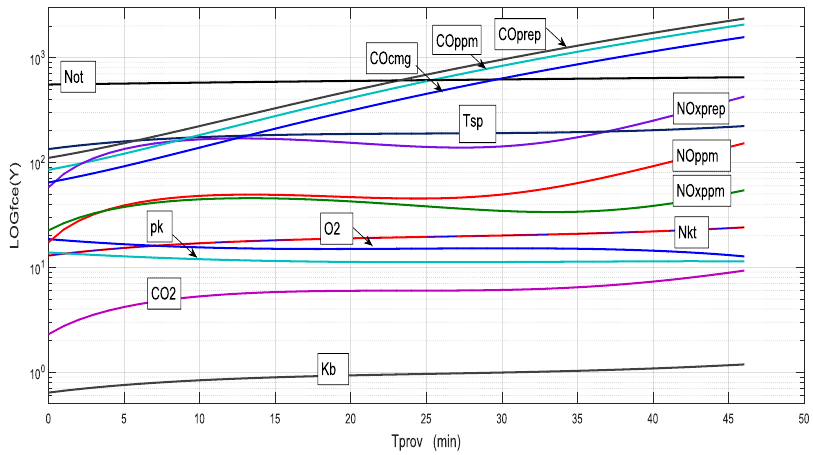
Figure 8. Distribution of functions depending on operation time Tprov; boiler MAGA 23.